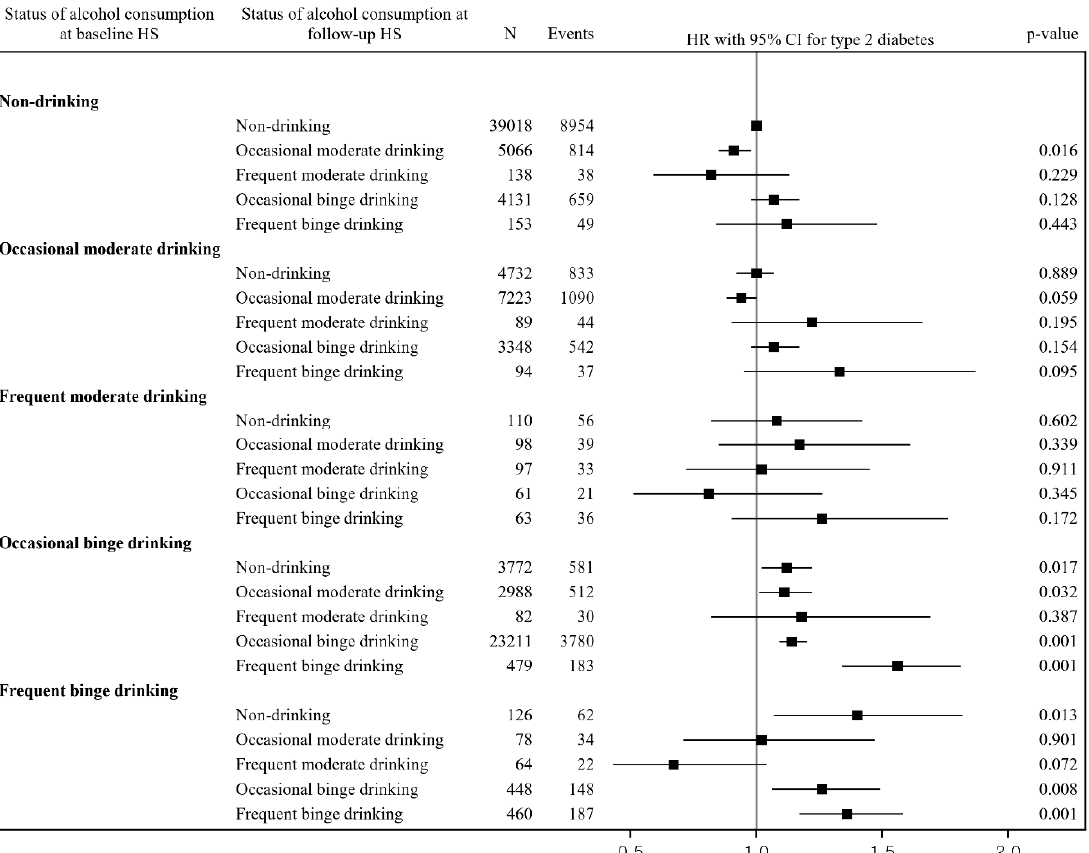
Figure 3. Relationship between changes in alcohol consumption and risk of type 2 diabetes. Abbre- viations: CI = confidence interval; HR = hazard ratio; HS = health screening. The HR and 95% CI were estimated after adjusting for sex, age, BMI, fasting glucose, total cholesterol, family history of diabetes, smoking status, exercise, nutrition intake behaviors, household income, residential area, and comorbidities.